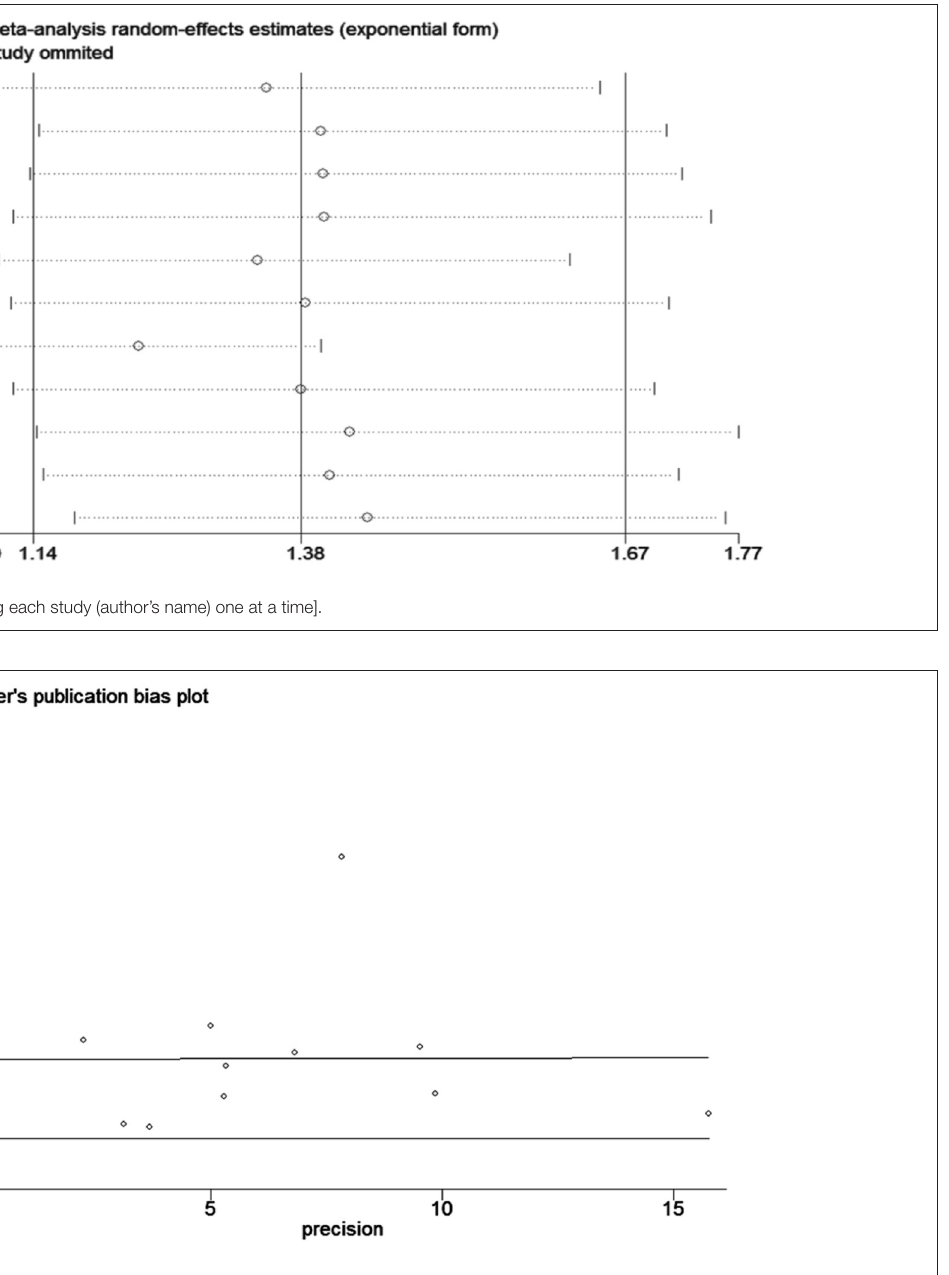
FIGURE 6 | The funnel plot of publication